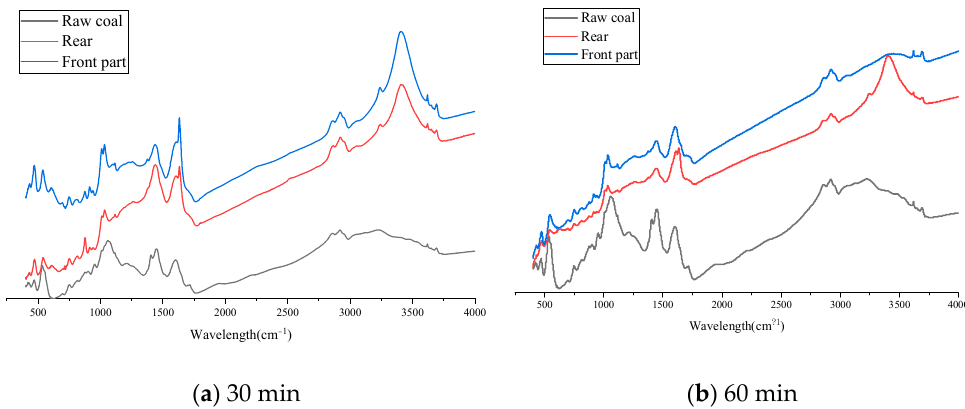
Figure 14. Schematic diagram of infrared spectrum of MgCl 2 . ( a ) is the infrared spectrum when the atomization time is 30 min; and ( b ) is the infrared spectrum when the atomization time is 60 min. In Figure 14, 3407 cm − 1 is the attribution peak of hydroxyl, 2858 cm − 1 and 2923 cm − 1 are the asymmetric vibration of methyl and methylene, respectively, the stretching vibration of the carboxyl functional group near 1627 cm − 1 , and the shear vibration of methylene are 1435 cm − 1 .